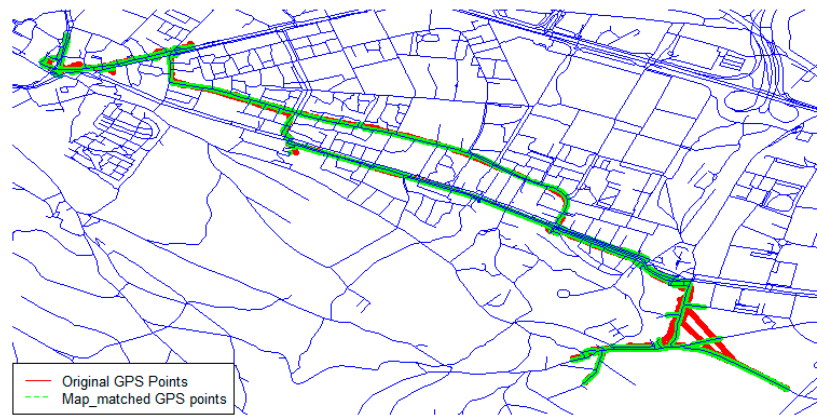
Figure 2. Map-matched global positioning system (GPS) points of data collected by a single in real-life using OpenStreetMap (OSM) participant in real-life using OpenStreetMap (OSM) data.